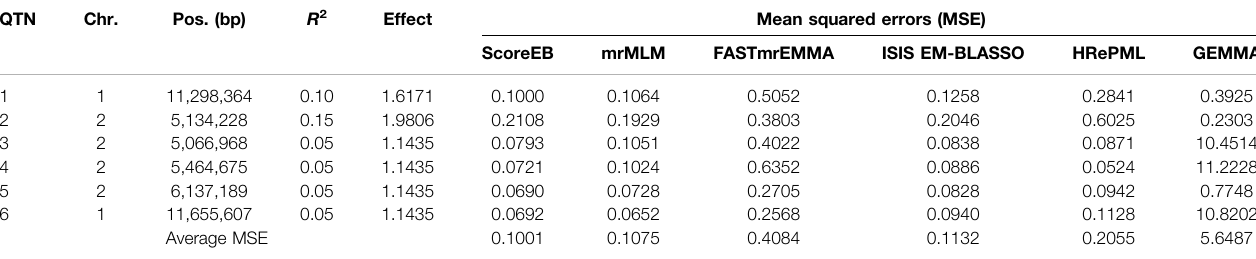
TABLE 1 | Comparison of mean squared errors (MSE) for each QTN among ScoreEB, mrMLM, FASTmrEMMA, ISIS EM-BLASSO, HRePML and GEMMA methods in the fi rst simulation study a . QTN